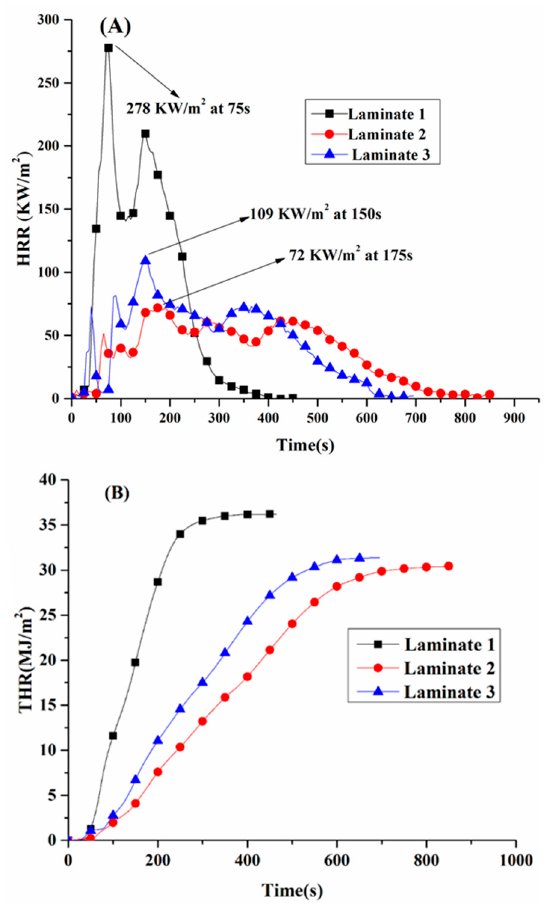
Figure 5. HRR ( A ) and total heat release (THR) ( B ) curves of different samples.